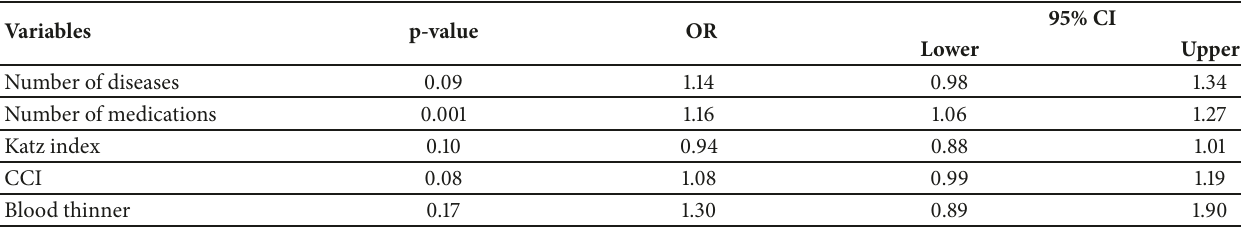
Table 2: Multivariable binary logistic regression prediction model.